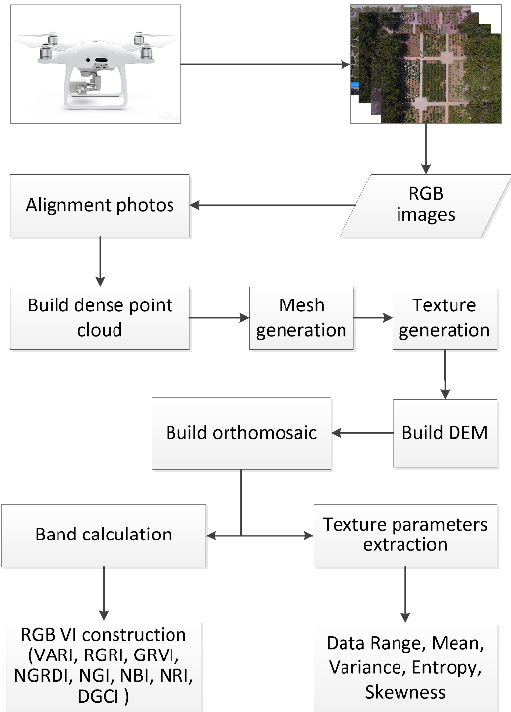
Figure 3. Unmanned aerial vehicle (UAV) image mosaic and information extraction.